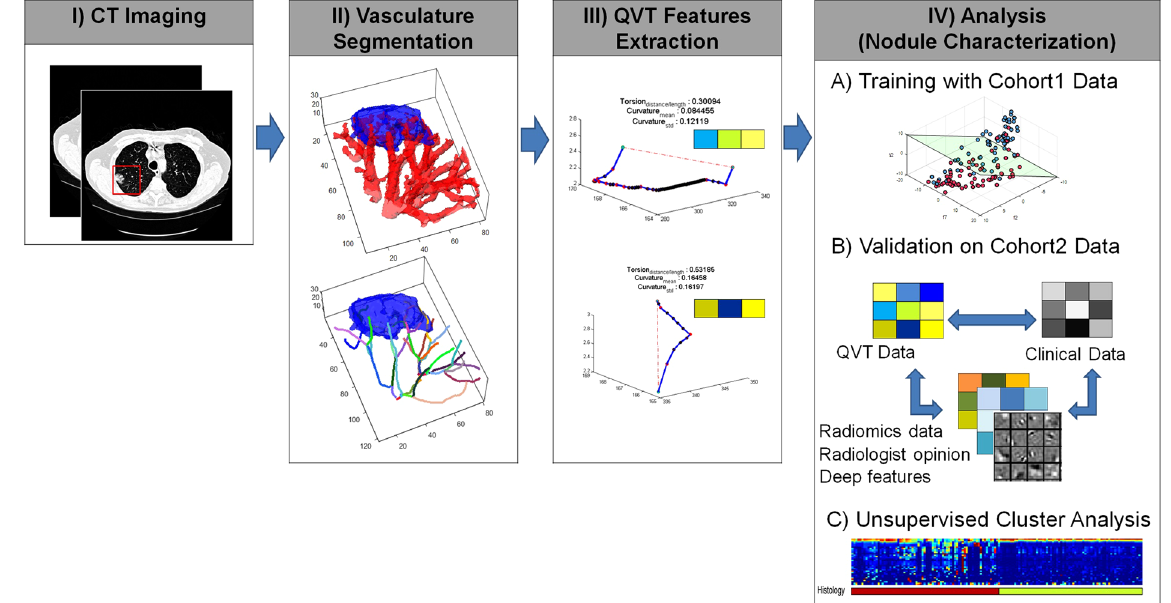
Figure 1. Illustration of workflow for capturing QVT features from chest CT scans. The goal of processing flow is to determine the malignancy probability for the input nodule in a CT image. In step 1, a 3D volume of interest was manually defined around the nodule of interest. In step 2, the associated vasculature was segmented using a 3D region growing algorithm, following which center lines of the vessels are extracted by the fast marching algorithm. In step 3, a set of 35 QVT features were extracted. Step 4 includes data analysis in which the stable and discriminating QVT features were used to train machine learning classifiers to predict the risk of nodule malignancy in the validation set. Unsupervised cluster analysis is then employed to find the association of clinical outcome with the QVT features. These features were also evaluated via human-machine comparison studies and were also compared against the predictive performance of texture and shape radiomics as well as deep